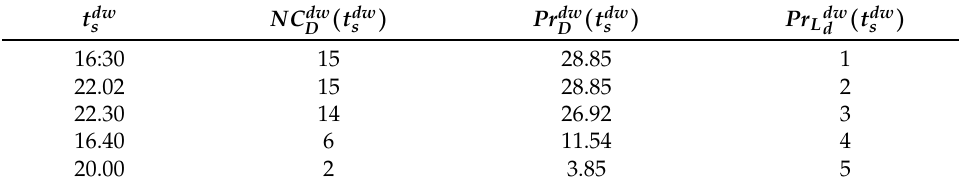
Table 10. Priority level values for t dw s for Scenario 2.